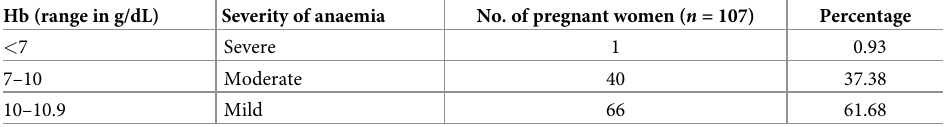
Table 1. Distribution of anaemia among pregnant women according to severity in Mbeya Tanzania (n = 107). Hb (range in g/dL) Severity of